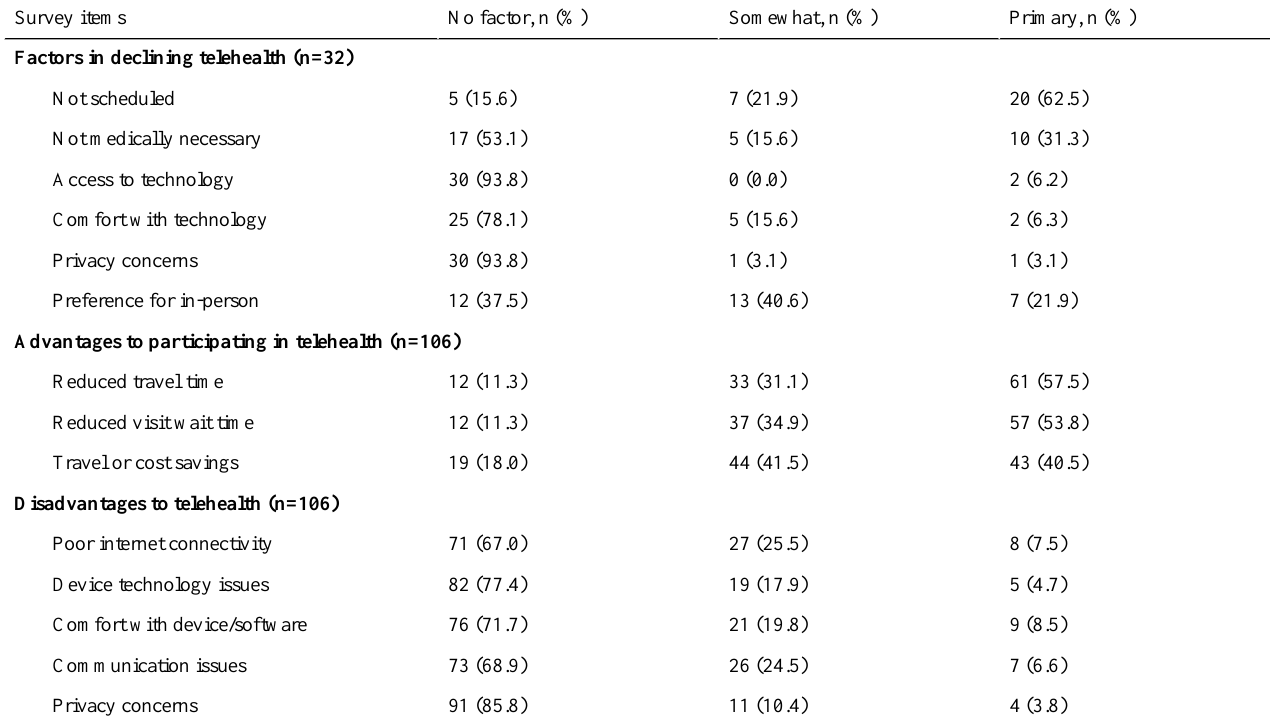
Table 1. Distribution of responses to survey items relating to respondents’ basis for opting out of telehealth and perceived advantages/disadvantages of telehealth by those who had a telehealth appointment.